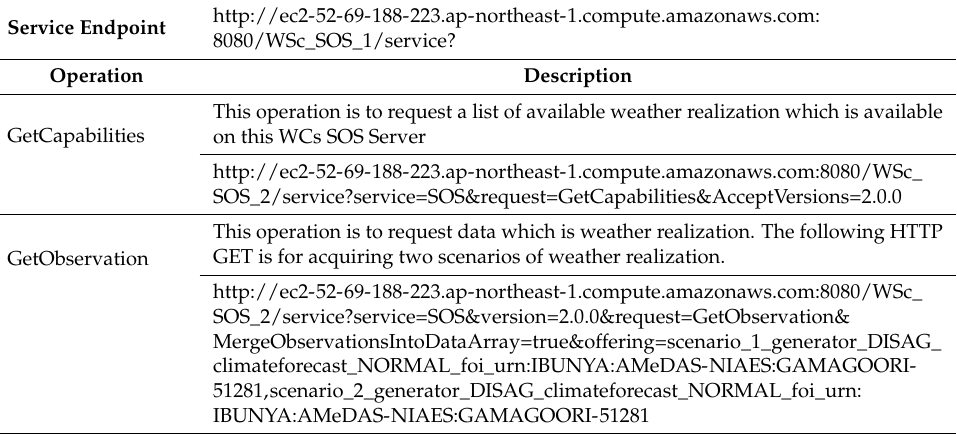
Table 6. Request parameter of the predictWTD service.